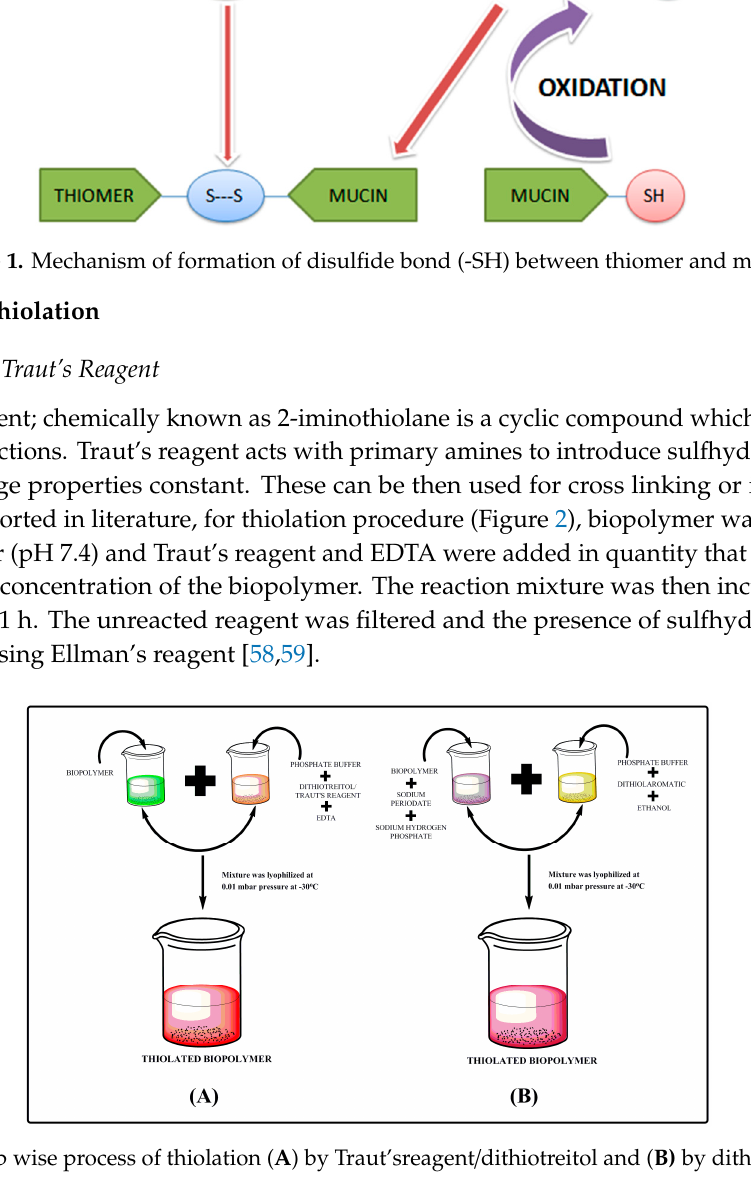
Figure 1. Mechanism of formation of disulfide bond (-SH) between thiomer and mucin.